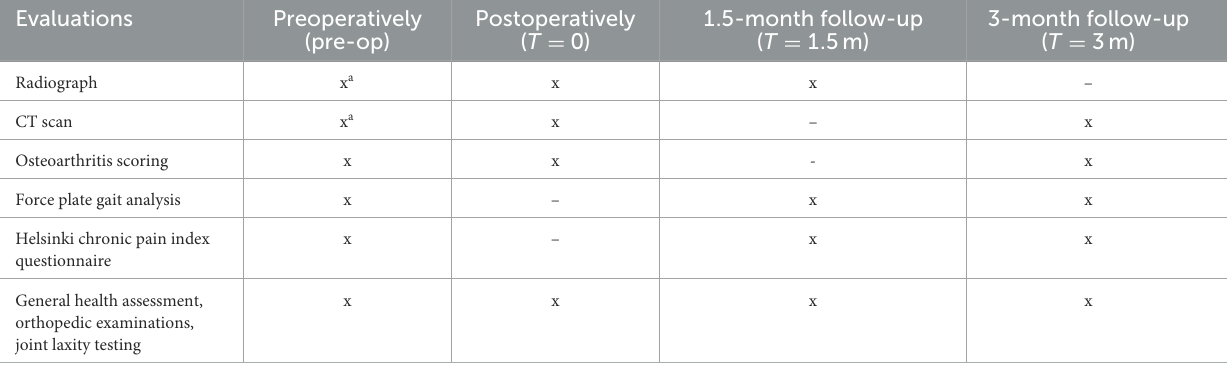
TABLE 1 Study outline in months (m).